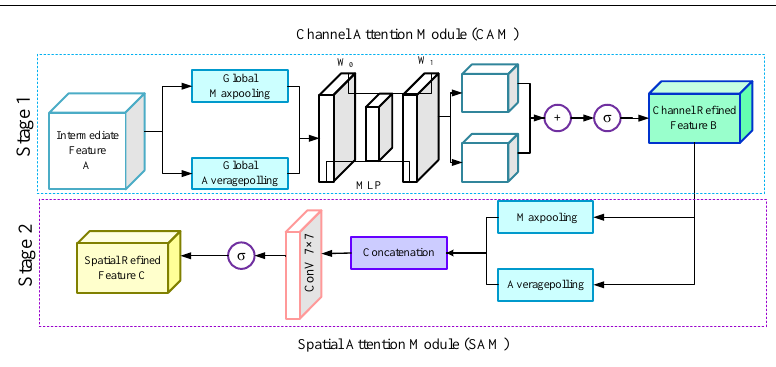
Figure 3. Structure of the CBAM